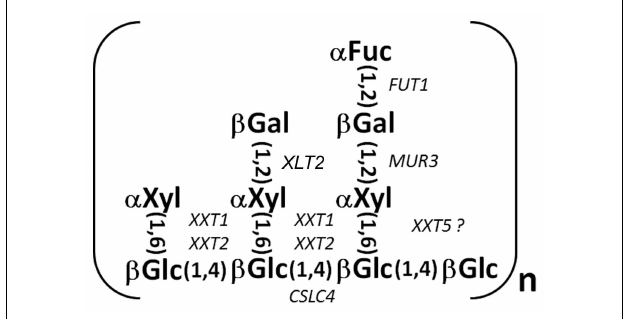
FIGURE 1 |The structure of the XLFG XyG subunit. Glycosyl transferases known to form particular linkages are shown in corresponding positions. The catalytic activity of XXT5 and XLT2 has not been